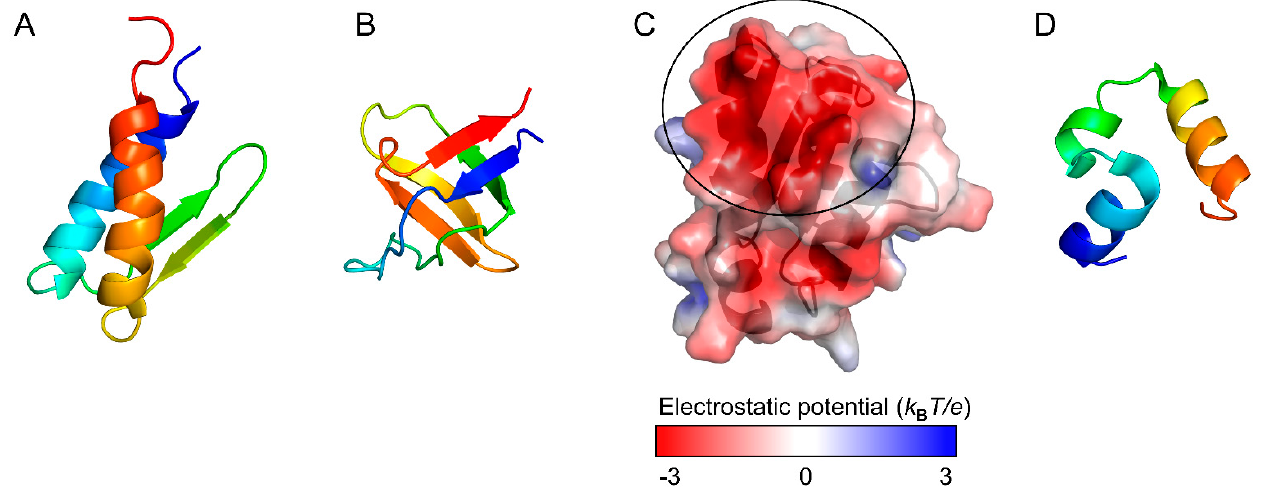
Figure 4. Native structures of gpW (PDB ID: 1HYW) ( A ) and the SH3 domain (PDB ID: 1SHG) ( B ). ( C ) Electrostatic potential energy surface of barstar (PDB ID: 1BTA). The black circle shows the barnase-binding site with large negative potentials. The electrostatic potential was calculated by APBS [76]. ( D ) Native structure of the 35-residue subdomain from the villin headpiece (PDB ID: 1YRF). Figures were drawn using PyMOL Molecular Graphics System, Version 2.4.0 Schrödinger, LLC.